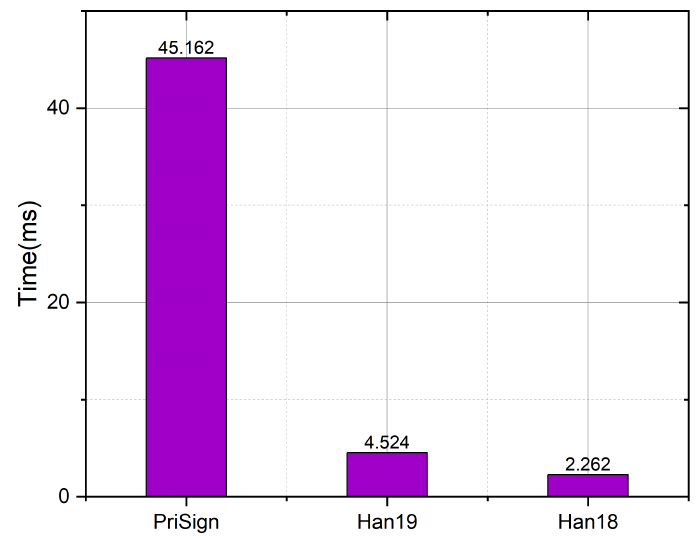
Figure 17. Time comparison with Han19 [9] and Han18 [8] in SignOn